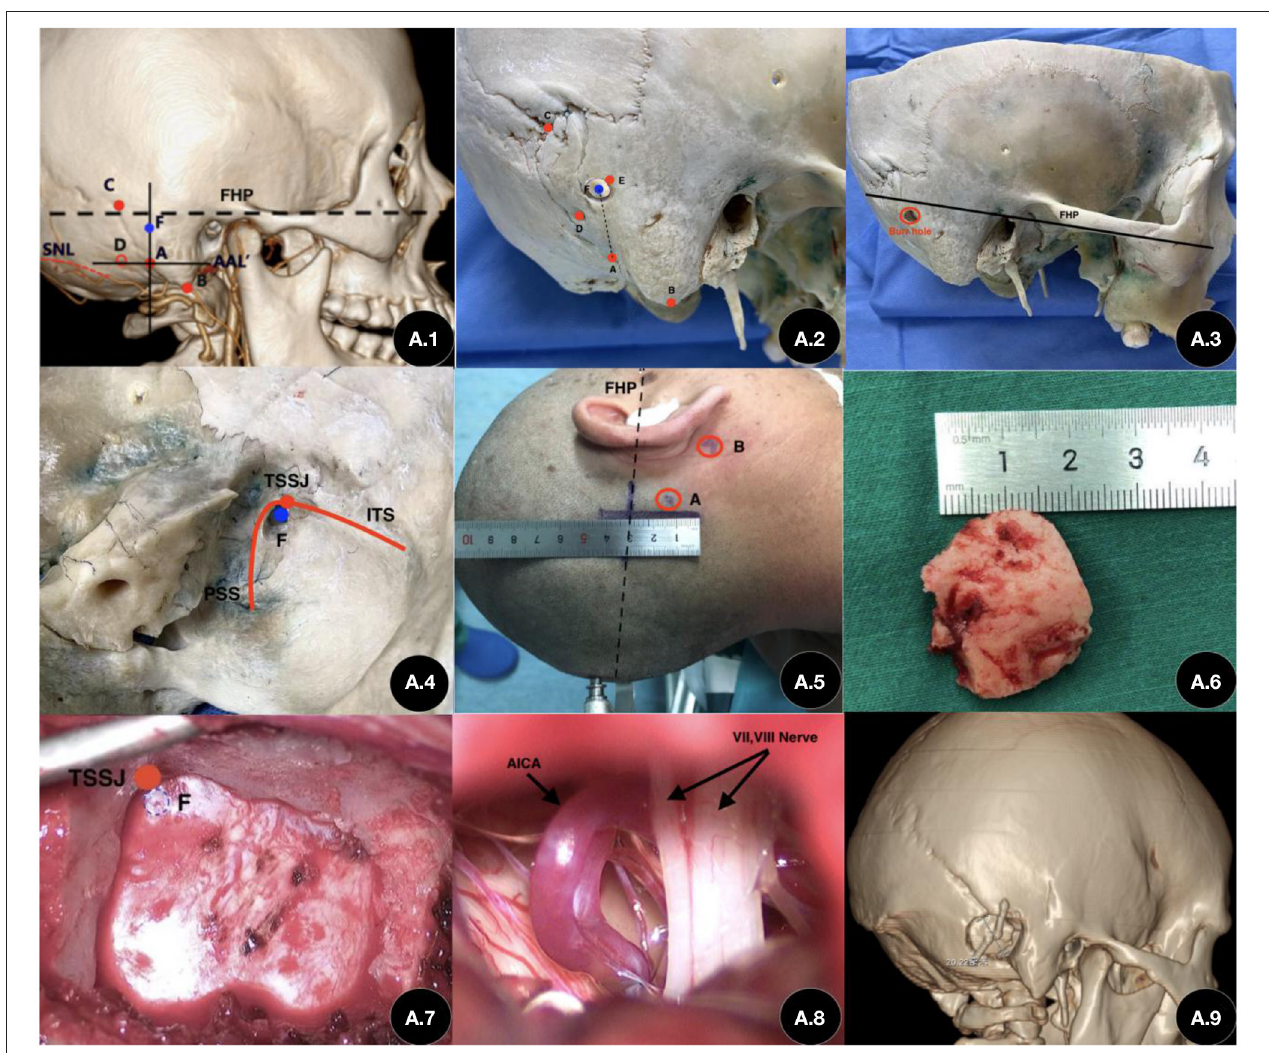
FIGURE 1 | Application of our method in craniotomy with a retrosigmoid keyhole approach. (A.1) Preoperative three-dimensional reconstructed images and related anatomical landmarks. (A.2) The center of burr hole, located approximately 12mm superior to the top point of the mastoid groove on the vertical line (A–F). (A.3) The Frankfurt horizontal plane (FHP) and the burr hole. (A.4) Inner view of the transverse sinus–posterior margin of the sigmoid sinus junction (TSSJ) and the center point of the burr hole. (A.5) Intraoperative incision ( ∼ 4cm). (A.6) Size of the bone flap. (A.7) Exposure of the bone window during the operation. (A.8) Exposure during MVD surgery. (A.9) Three-dimensional reconstruction images after the operation. (A) Top point of the mastoid groove. (B) Mastoid apex. (C) Asterion. (D) Foramen venosum of the mastoid emissary vein. (E) Keypoint (the correspondence point to the transverse-sigmoid sinus junction on the external surface of the skull). (F) Center point of the burr hole. (FHP) Linen parallel line to the line between the infraorbital margin and the upper edge of the external auditory canal. (TSSJ) Transverse-Sigmoid Sinus Junction. (PSS) Posterior edge of Sigmoid Sinus. (ITS) Inferior edge of Transeverse